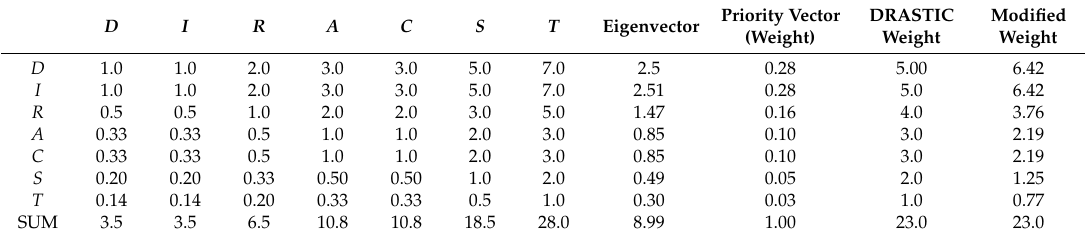
Table 4. Pair wise comparisons matrix for selecting suitable landfill site, Eigenvector, and significance